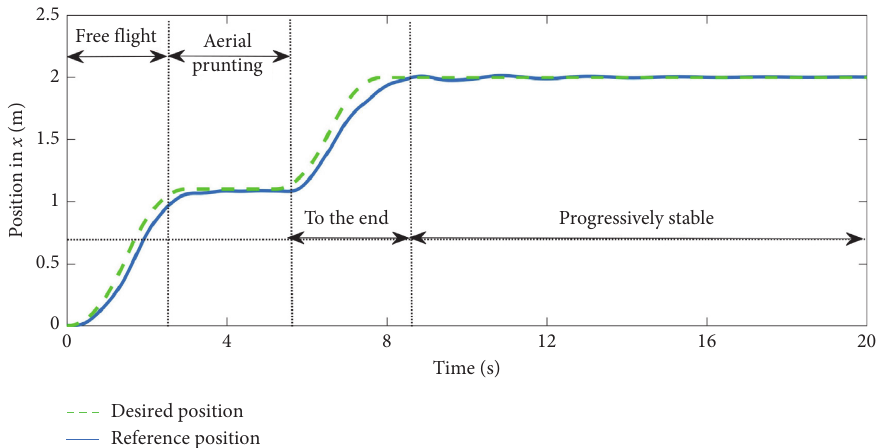
Figure 9: Position changes of ARSS during the pruning.